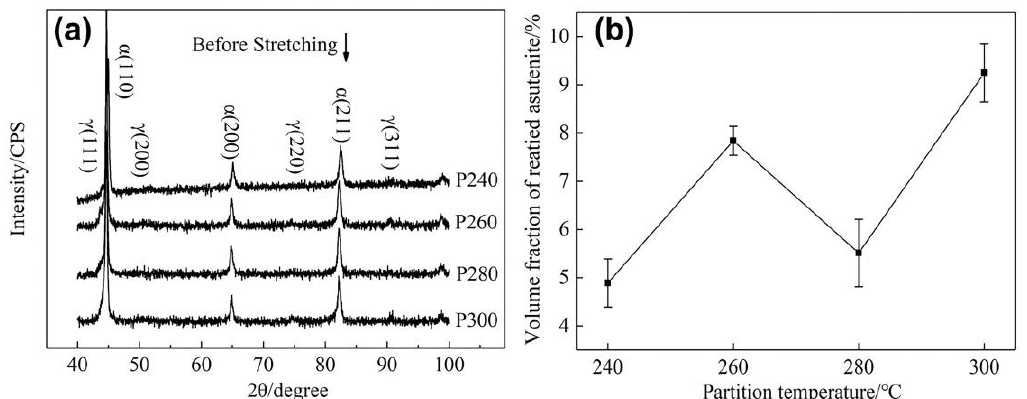
Figure 4. Experimental steels at different partition temperatures: ( a ) XRD pattern; ( b ) volume fraction of retained austenite.